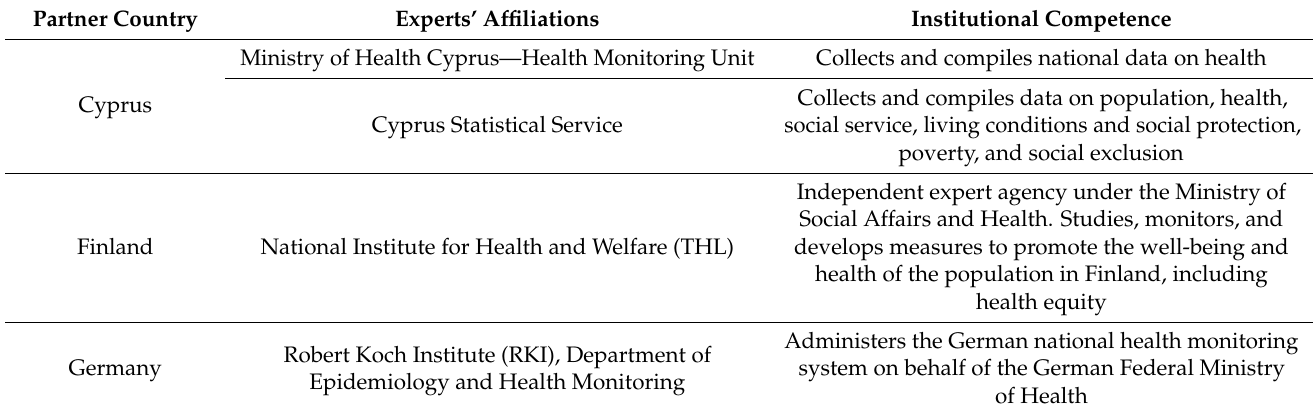
Table 1. Affiliations of the experts participating in the country assessments and description of the institutional competence for this